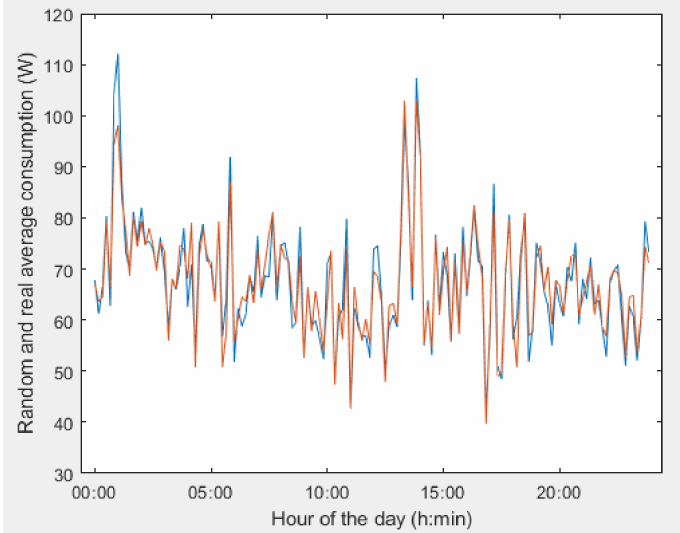
Figure 7. Random (blue) and real (orange) average consumption of the refrigerator during working